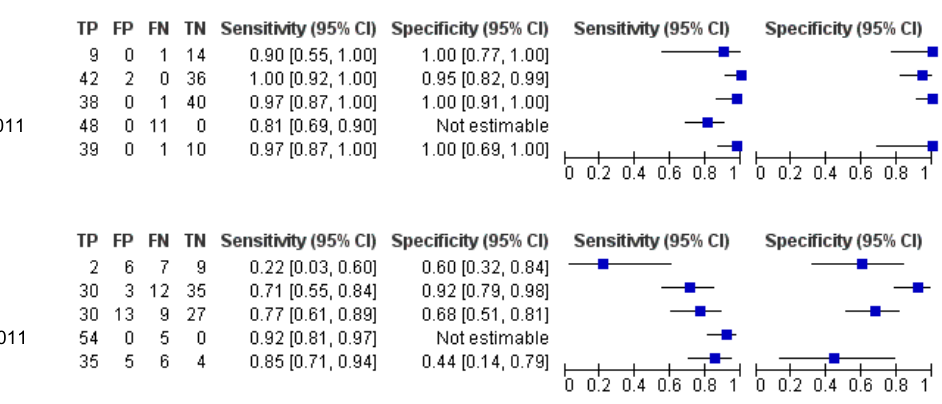
Figure 3. Forest plots demonstrating the sensitivity ( left ) and specificity ( right ) [7,10–12,27]. Bivariate meta-analysis demonstrated a higher pooled mean sensitivity with PO (93%; 95% confidence interval, 88.0% to 96.0%) compared with EPT (79.0%; 95% confi- dence interval, 73.0% to 85.0%). A higher pooled mean specificity with PO (98%; 95% con- fidence interval, 93% to 100%) was also observed as compared to EPT (74.0%; 95% confi- dence interval, 64.0% to 82.0%). Figure 4 illustrates the calculated summary ROC curves, including the summary operating points for sensitivity and specificity and 95% confi- dence ellipsoids.